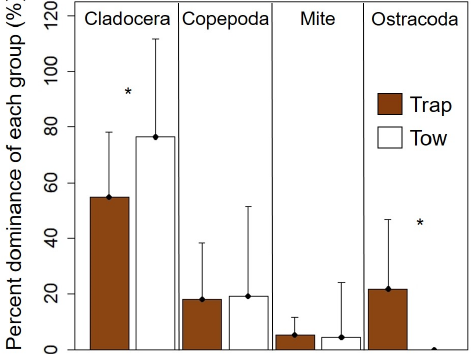
Figure 5. Percent density dominance of zooplankton groups collected in bladderwort traps in the littoral zone versus collected by tow nets just outside the bladderwort traps in the pelagic zone. Asterisks (*) above plots denote statistical difference for each analysis.